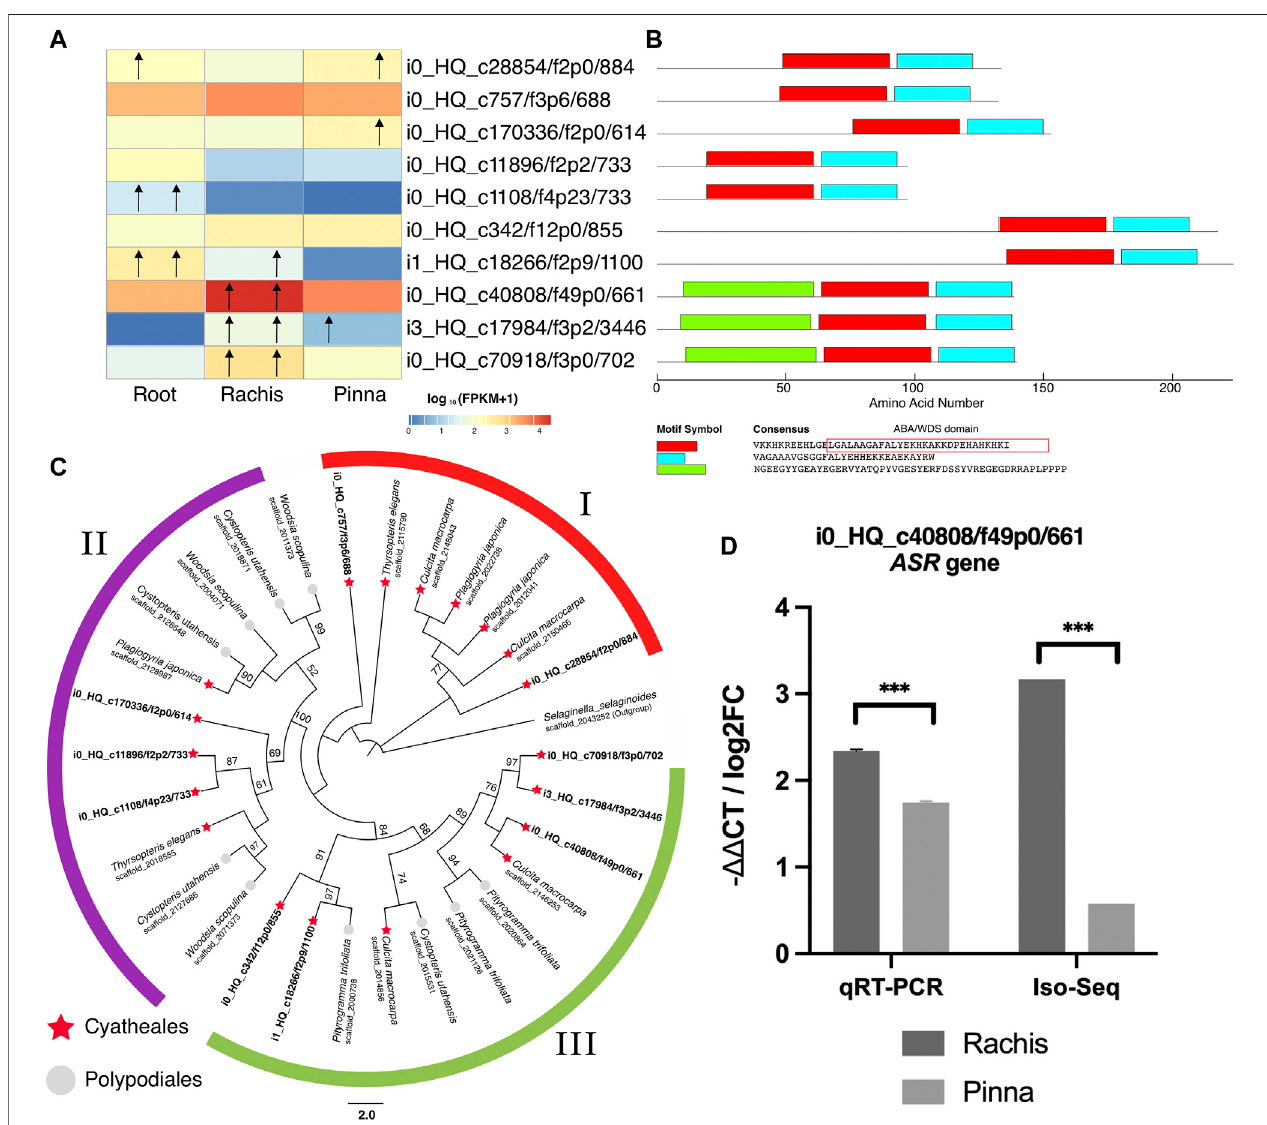
FIGURE 6 | Identi fi cation and pro fi ling of ASR gene family. (A) Expression pro fi ling of the ASR genes family in three organs as a heatmap. Root column: left/right arrows indicate upregulated genes in root versus rachis/pinna. Rachis column: left/right arrows indicate upregulated genes in rachis versus root/pinna. Pinna column: left/right arrows indicate upregulated genes in pinna versus root/rachis. (B) The conserved motif identi fi ed in the ASR genes family. The amino acid residues in the rectangleindicatedtheABA/WDSconserveddomain. (C) PhylogenetictreeofCyathealesandPolypodiales ASR genesfamilyconstructedbymaximumlikelihood. The number above the nodes indicates the bootstrap value, which was omitted if it was less than 50. (D) ASR FL unigene validation by RT-PCR.